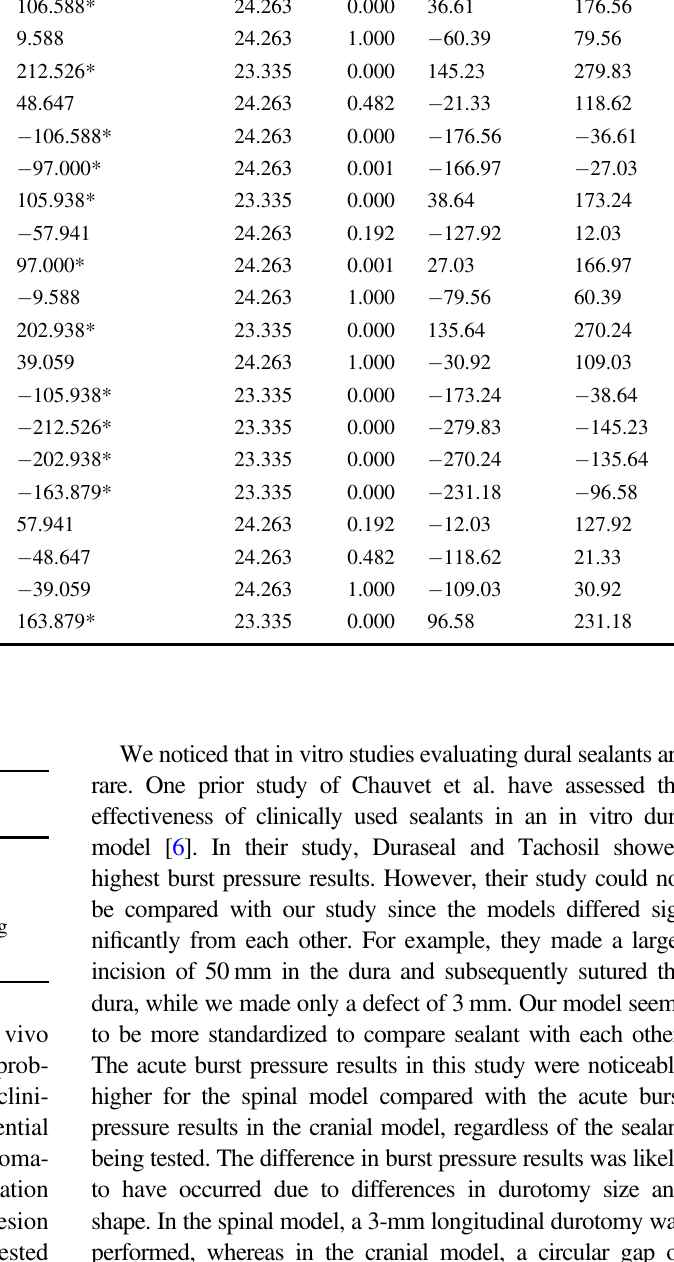
Table 2 Differences in mean burst pressure between sealants in the spinal setup adjusted for multiple comparisons with post- hoc Bonferroni correction